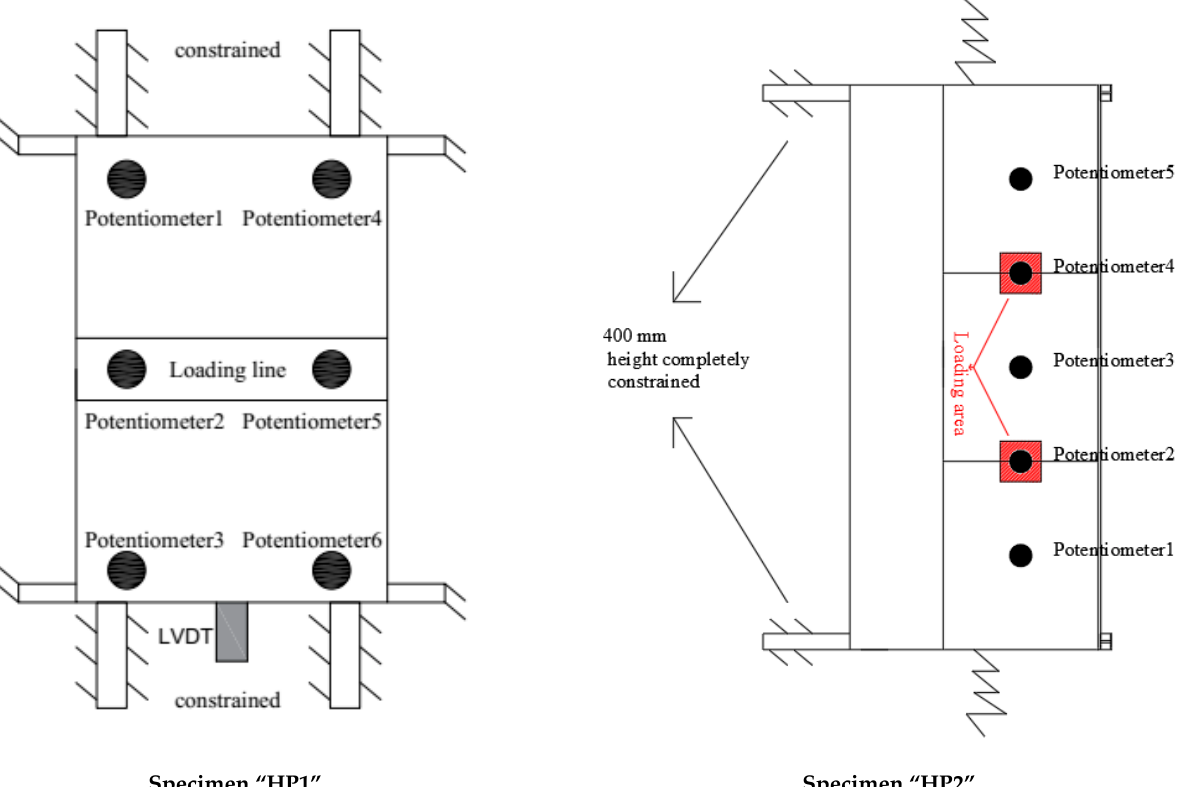
Figure 2. Setup of the monitoring and loading test for the hybrid structures. Potentiometers indicated as P and LVDT indicated as H.